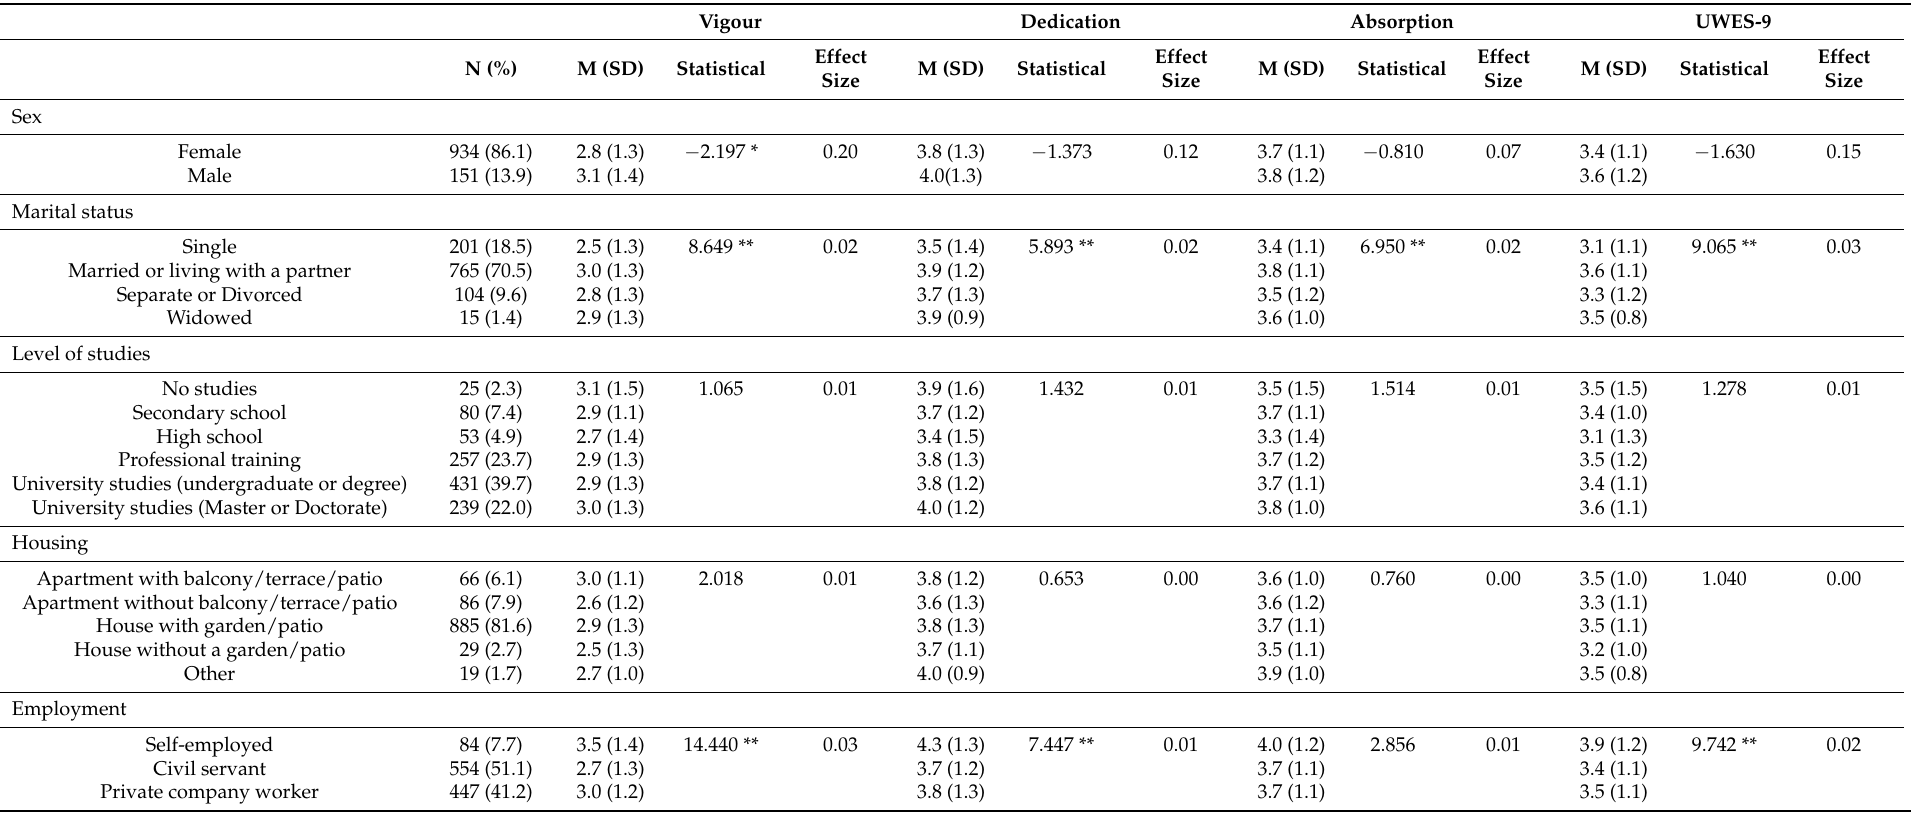
Table 1. UWES-9 dimensions related to sociodemographic variables (N =